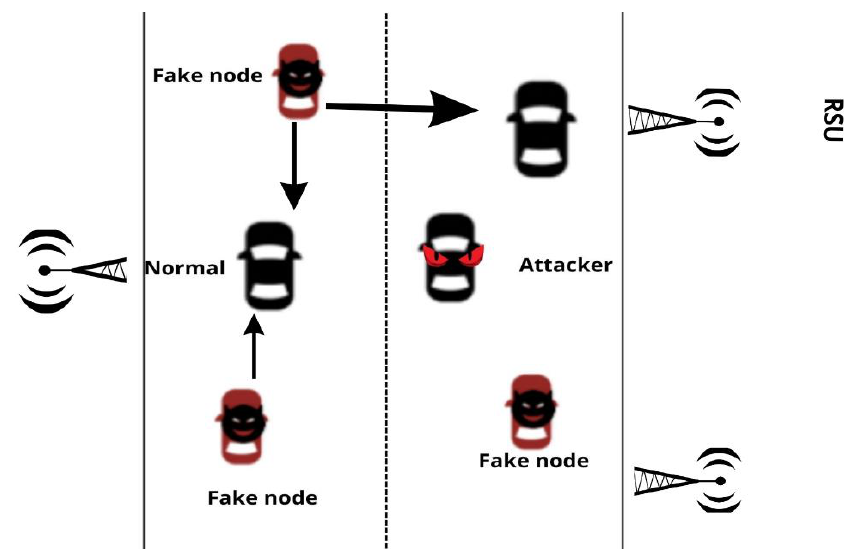
Figure 1. Sybil Attack scenario in VANET .